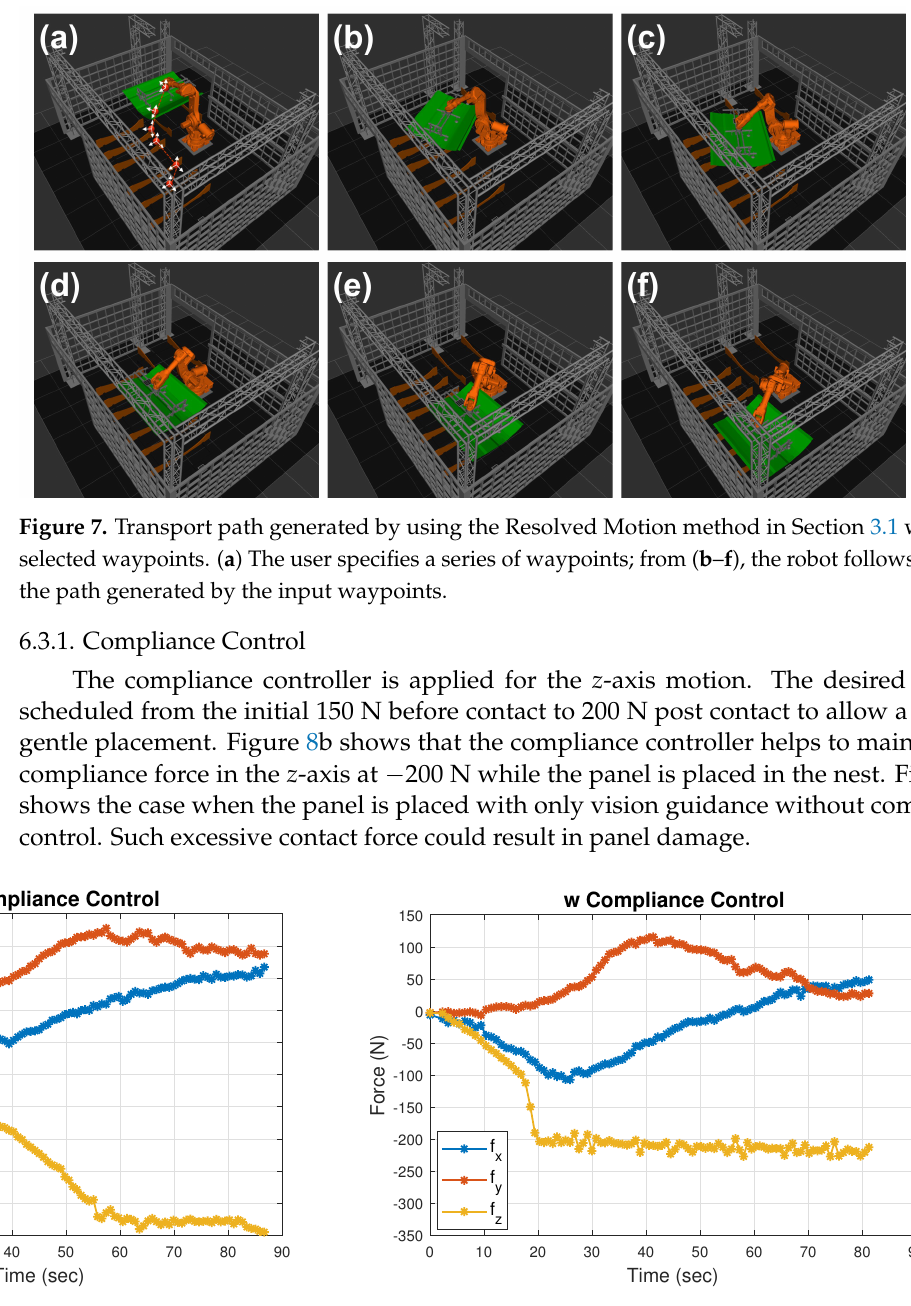
Figure 8. ( a ) Panel placement without compliance control risks high contact force (robot moves in the z direction for placing the panel in the assembly nest). ( b ) With compliance control, the placement force is regulated to the specified 200